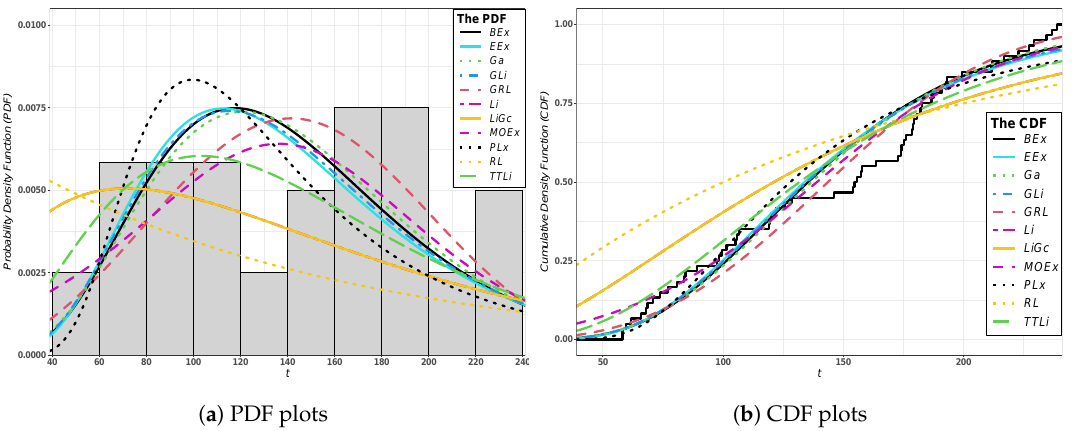
Figure 4. Fitted densities and distribution functions of the competing models for epicenter